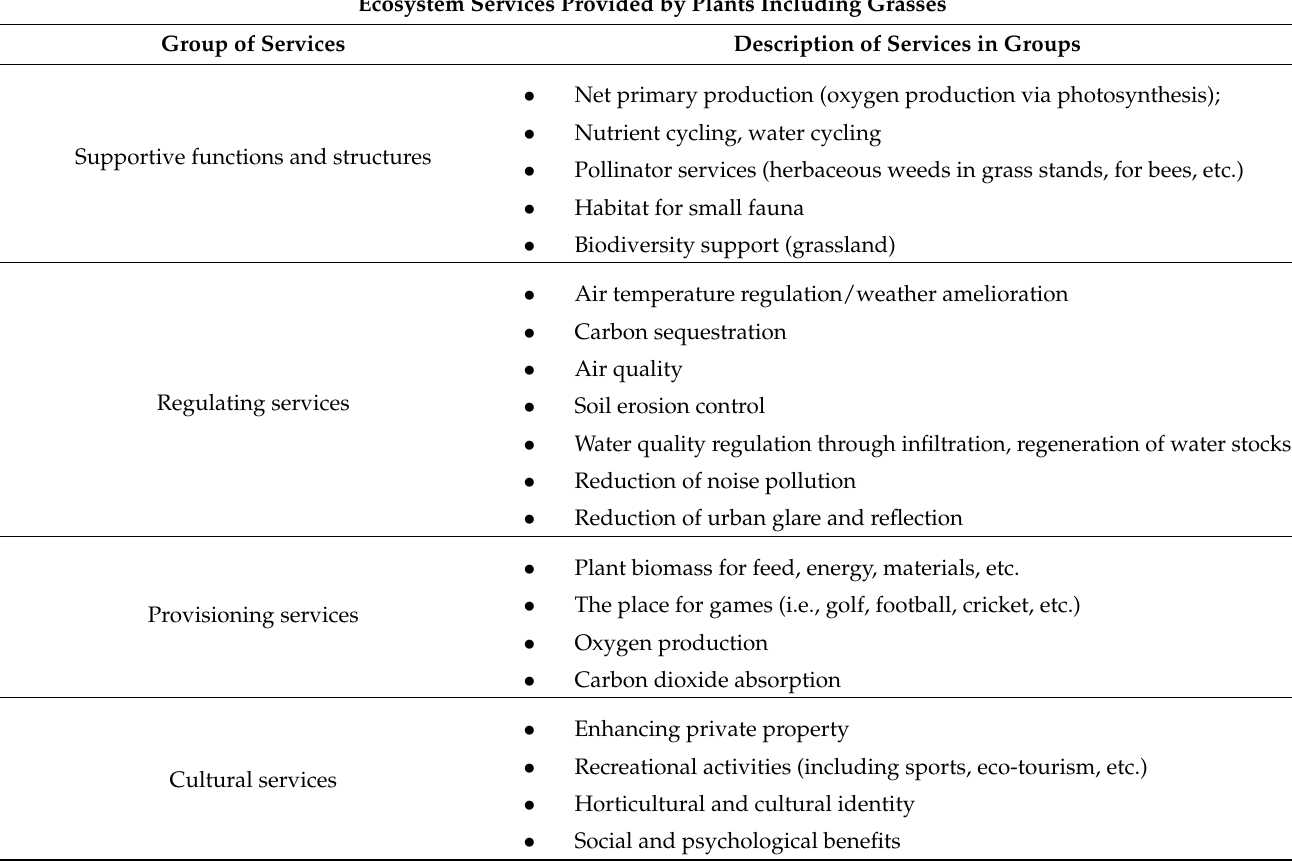
Table 1. Classification of ecosystem services